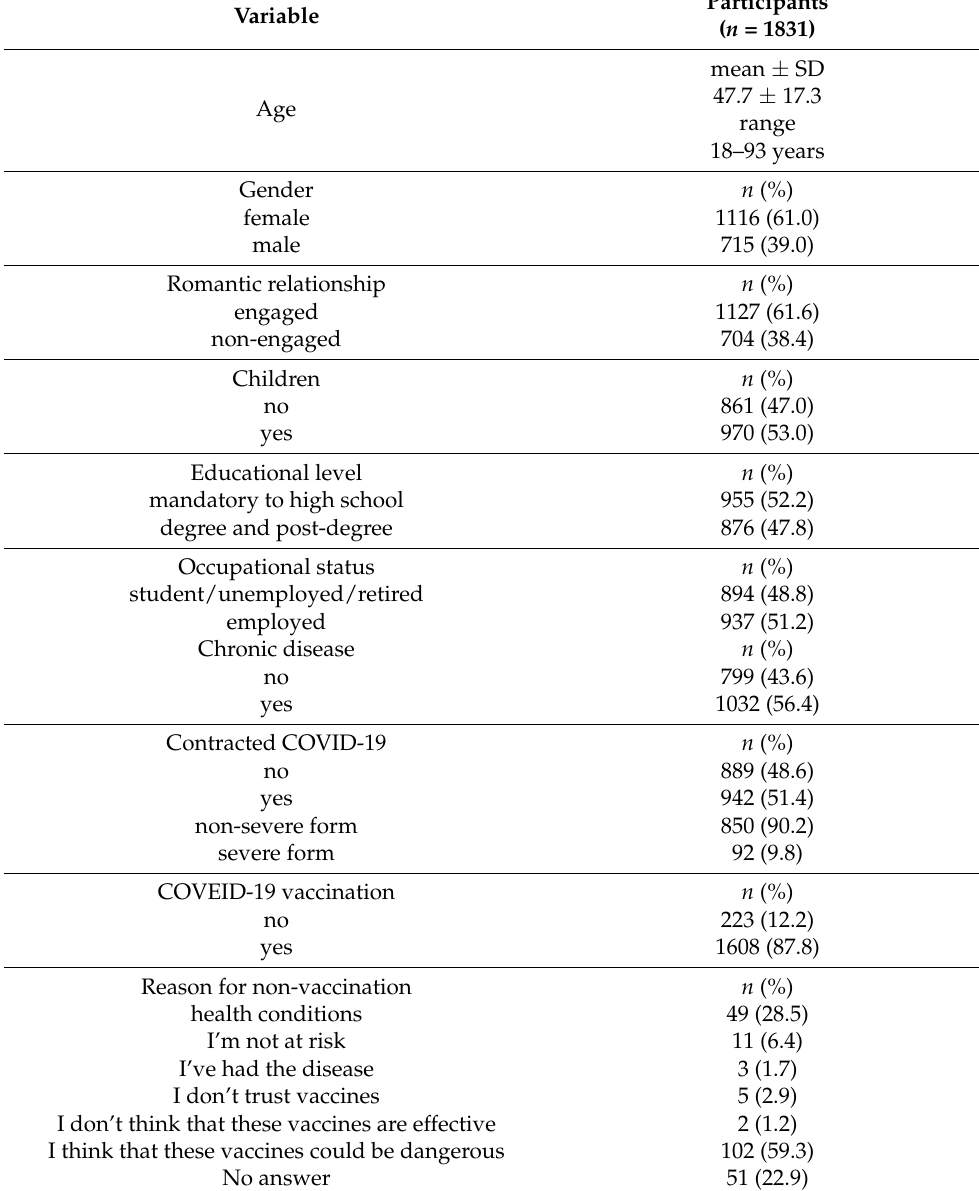
Table 1. Characteristics of the